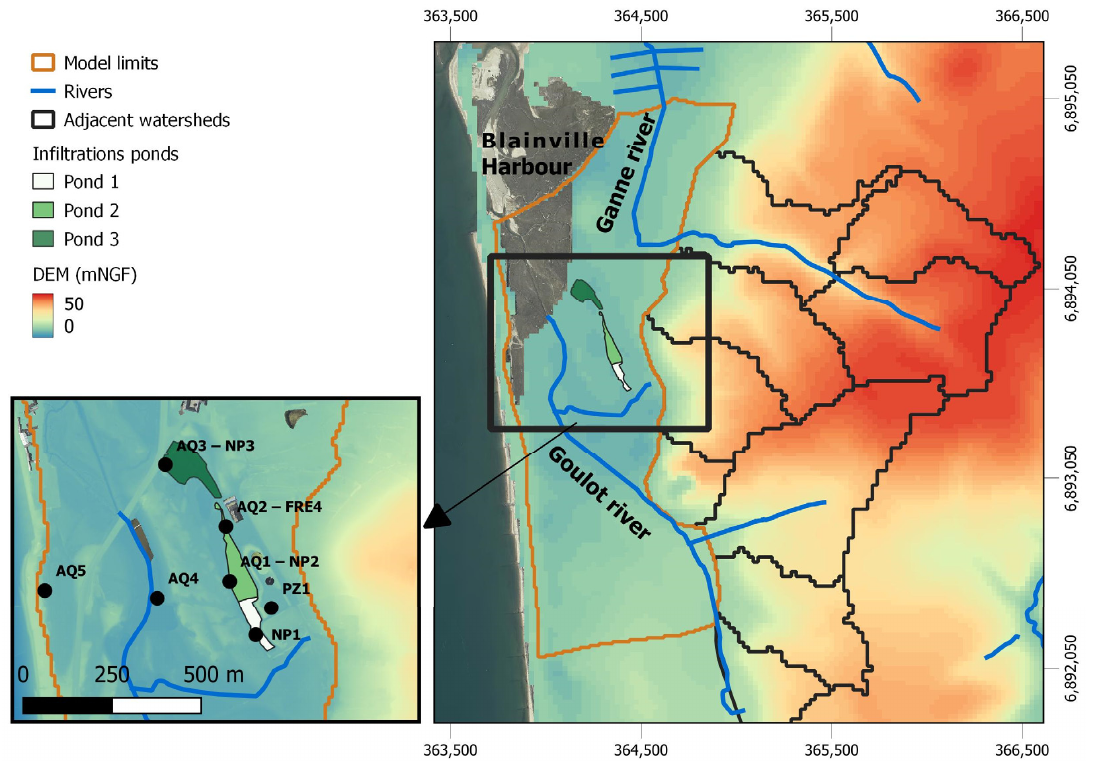
Figure 2. Topography (25 m DTM and 1 m DTM) and boundaries of the adjacent upstream watersheds and of the hydrogeological model, including the SAT system (infiltration ponds).